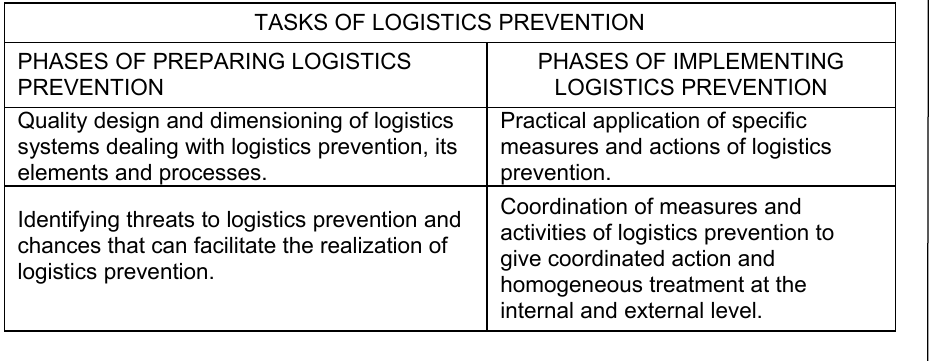
Table 3 – Logistics prevention phases and